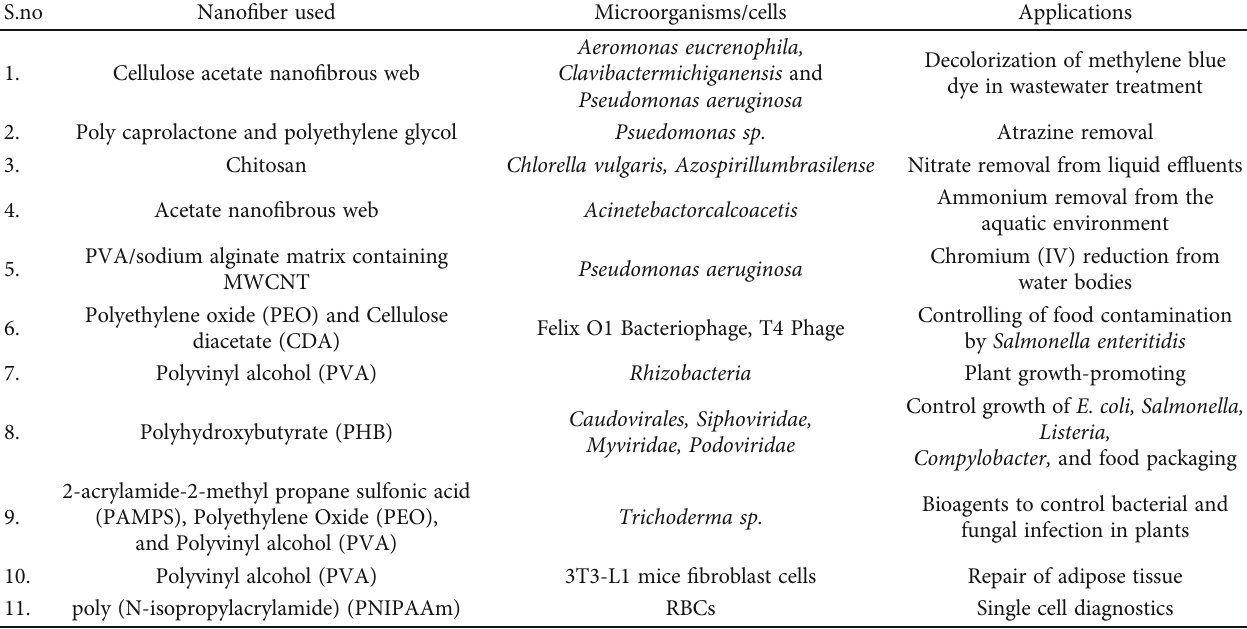
Table 1: Di ff erent nano fi bers used for di ff erent microorganisms and their